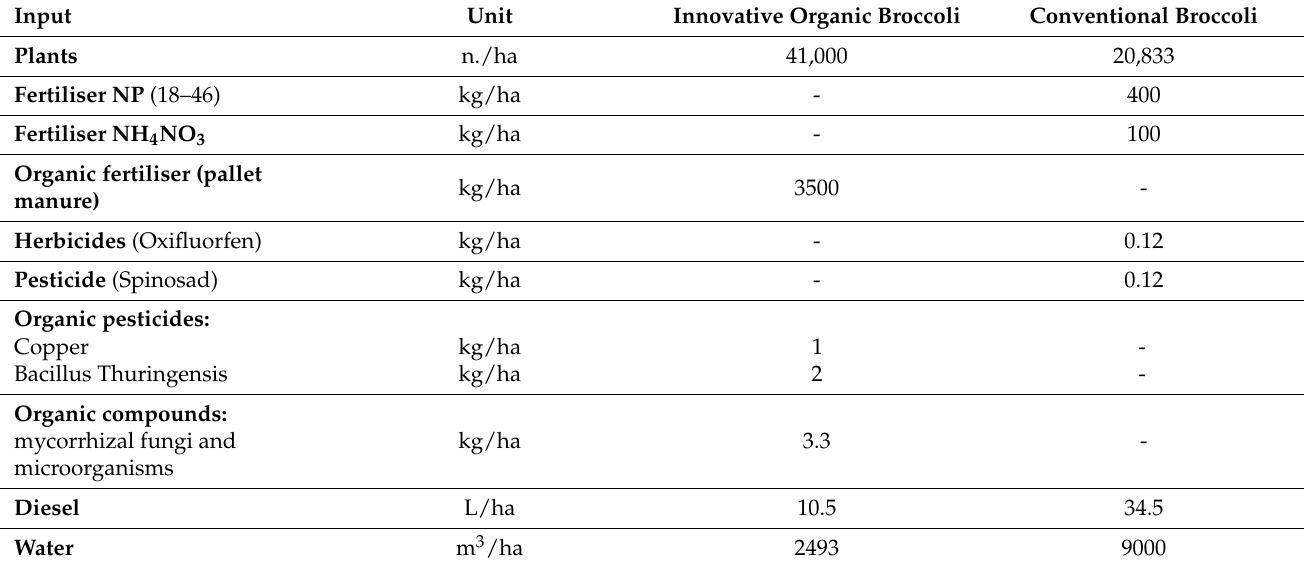
Table 1. Inputs used in innovative organic and conventional broccoli cultivation